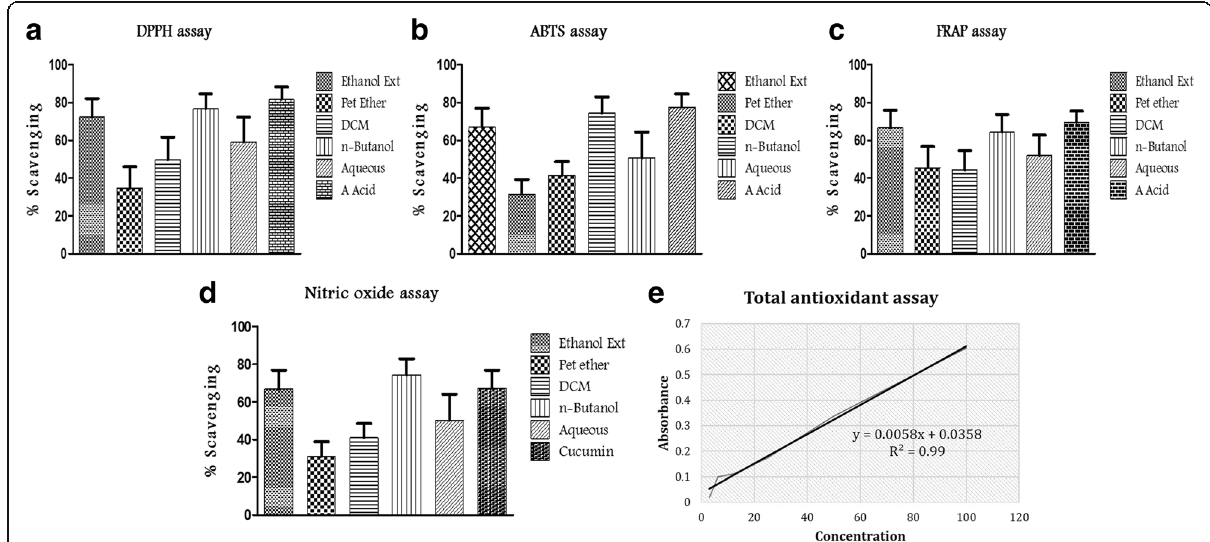
Fig. 2 In vitro antioxidant assays of T cordifolia. Antioxidant activities of ethanol extracts and its fractions of T cordifolia. IC 50 values were calculated by mean percentage of Scavenging at different concentrations (12.5, 25, 50,100 and 200 μ g/mL). a ) DPPH assay b ) ABTS assay c ) FRAP assay d ) Nitric oxide assay e ) Total antioxidant